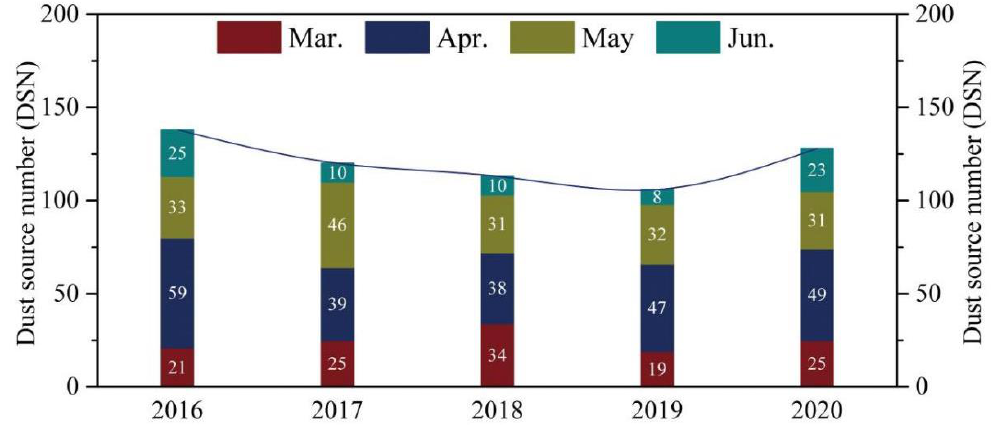
Figure 3. Temporal variation characteristics of dust source number (DSN) from 2016 to 2020.